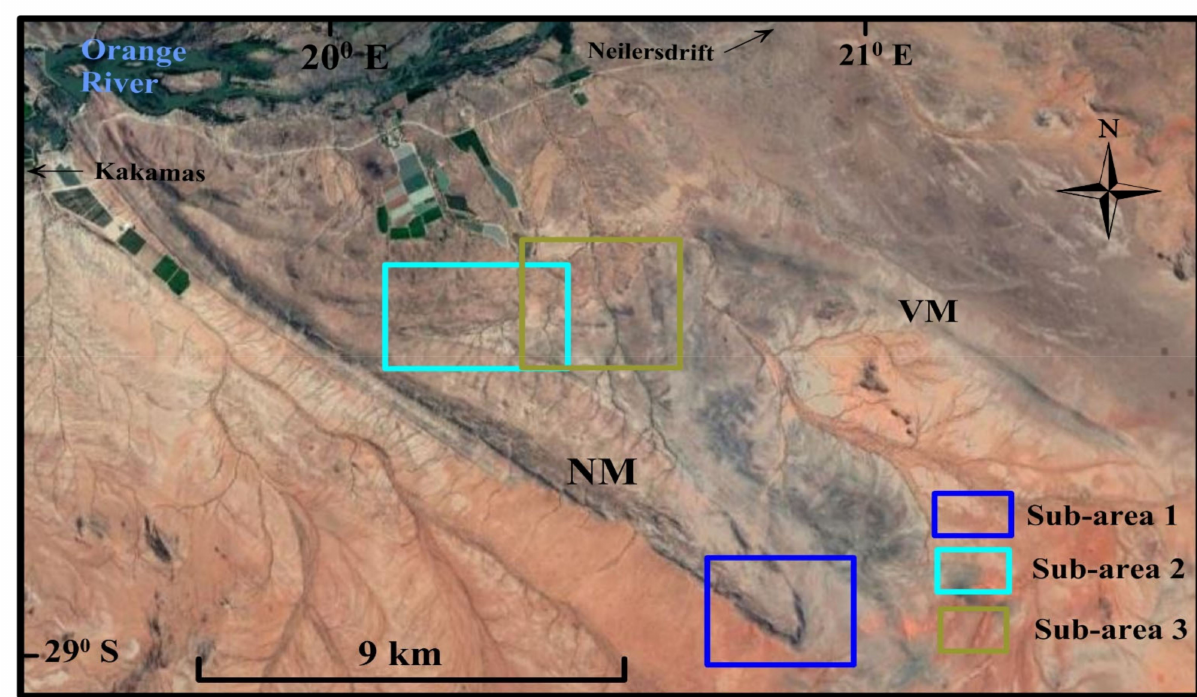
Figure 5. Satellite image showing the location of each sub-area on the Neusberg macrofold in the study area. F 2 folds occurred at M 2 metamorphic grade under conditions sufficient enough